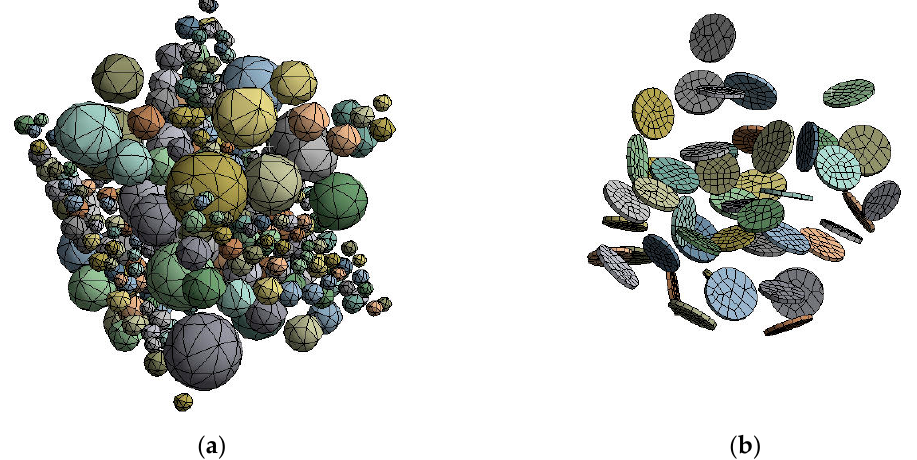
( b ) Figure 9. Macromechanical scheme of composite materials during compression pressing: 1 – matrix; 2, 6 – upper and lower punches; 3 – mandrel; 4 – powder weight; 5 – compressed tablet: experimental setup ( a ); solid-state simulation model ( b ). 4. Results and Discussion 4.1. Model Simulation Results